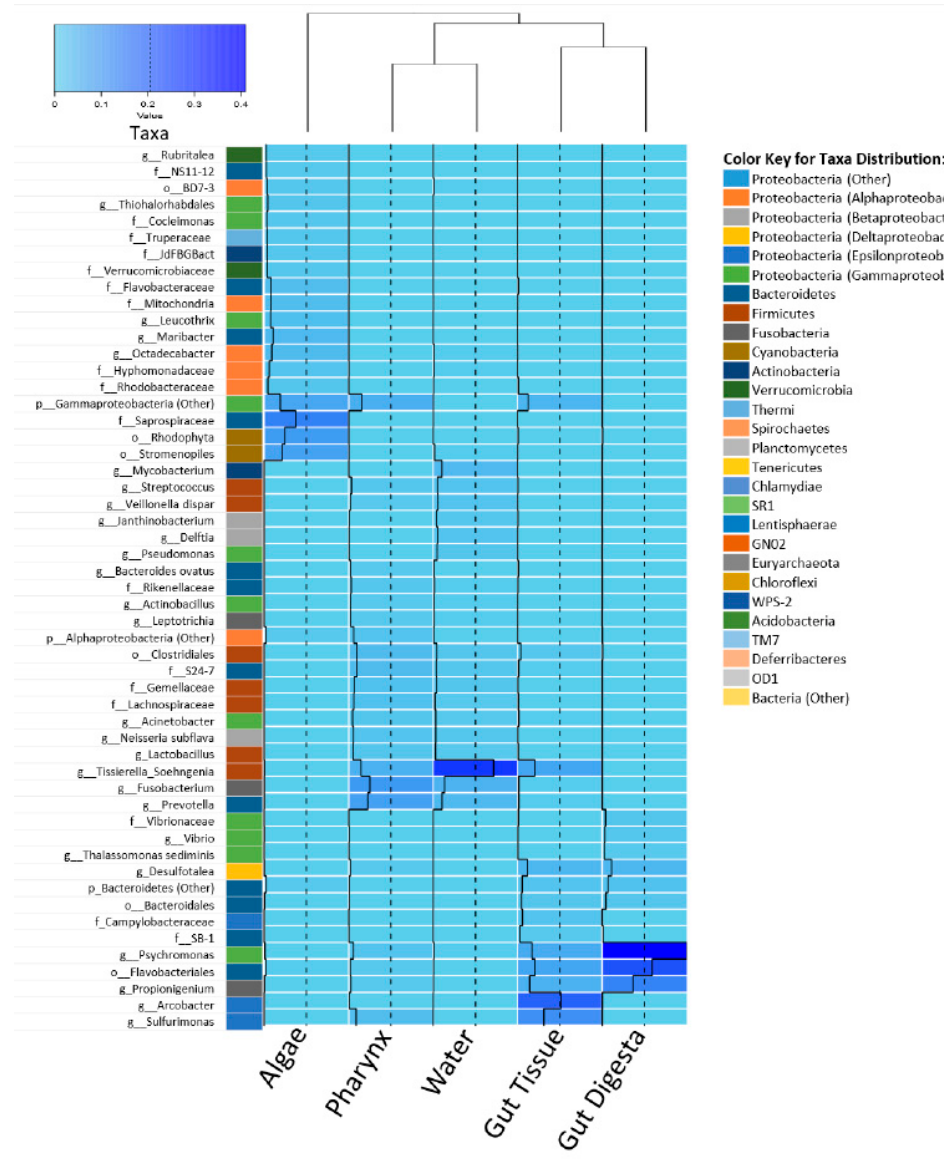
Figure 6. Heatmap of the top 53 taxa at the highest resolution, determined using the rarefied OTU table and generated using R (v3.3.2). The heatmap.2 function from the gplots (v3.0.1) package (www.rdocumentation.org/packages/gplots) was used. Sample dendrogram was generated using Vegan (v2.4.3), employing the Bray-Curtis metric of the grouped biological replicate count data. Color palette selected using the RColorBrewer package and set from “sky blue” for less abundant, to “blue” for more abundant (shown in color key). Relative abundance values of each taxon are also indicated through a trace line (black). The associated table includes the most resolvable taxonomic assignment according to the GreenGenes (v13.8) database, which is color-coded to the phylum level assignments (class for Proteobacteria) as indicated in the key and corresponding to the relative abundances in the Figure 2A relative abundance graphs. The figure has been generated using scalable graphics and, therefore, regions of interest can be viewed at a higher resolution digitally by increasing the